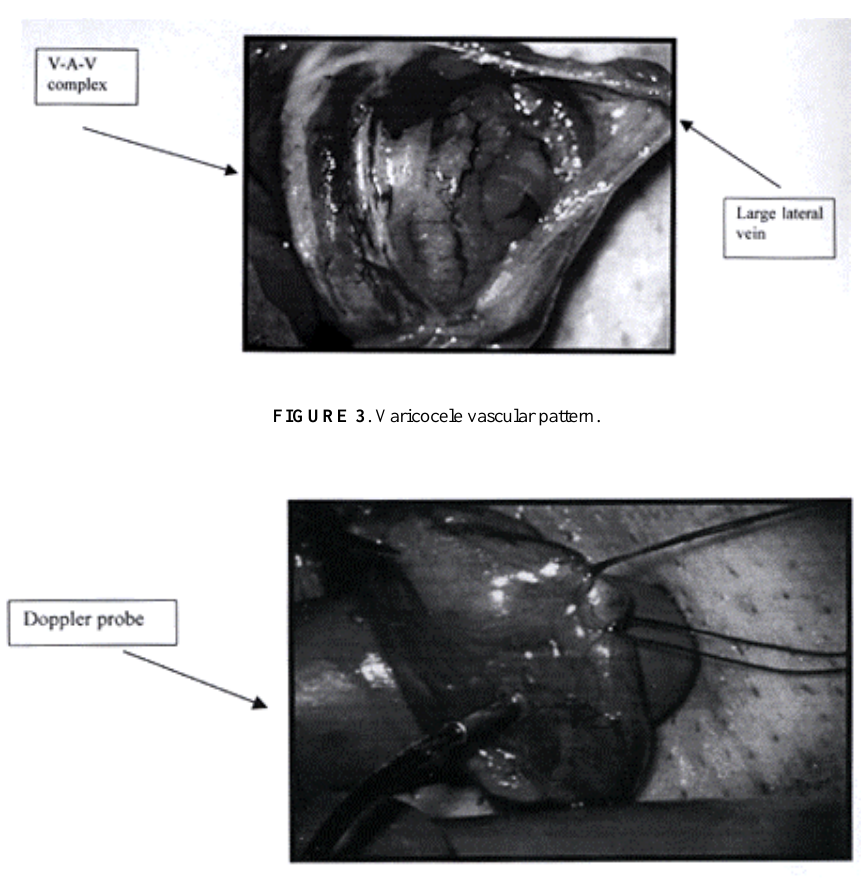
FIGURE 4 . Micro Doppler probe used